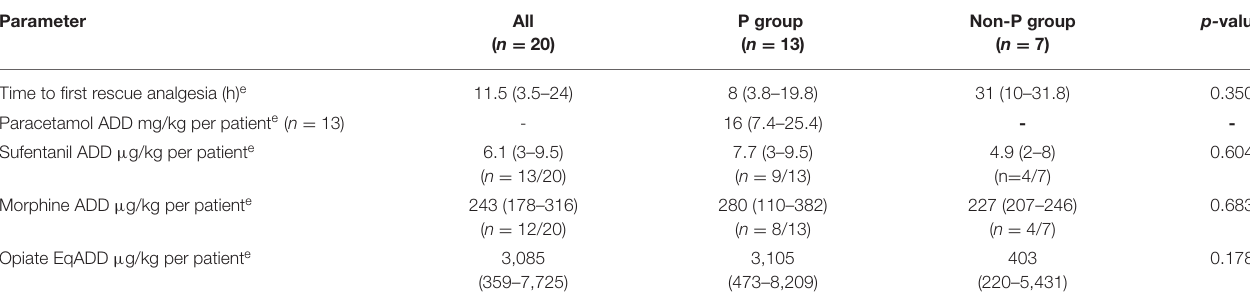
TABLE 4 | The average daily dose of analgesic drugs within 48h after surgery. Parameter All